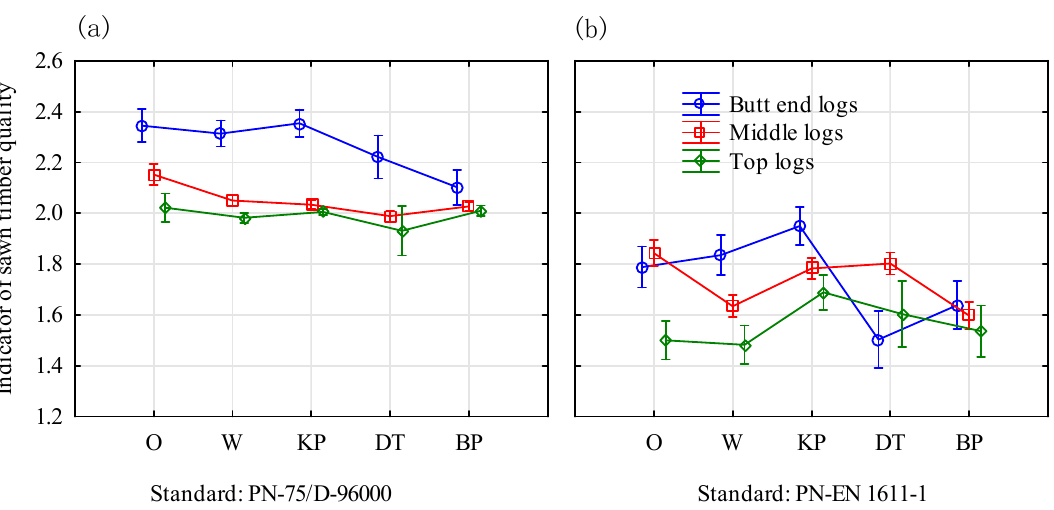
Figure 6. Quality classes for sawn timber from butt-end, middle and top logs, graded according to the Polish Standard (PN-75/D-96000) ( a ) and the European Standard (PN-EN 1611-1) ( b ).